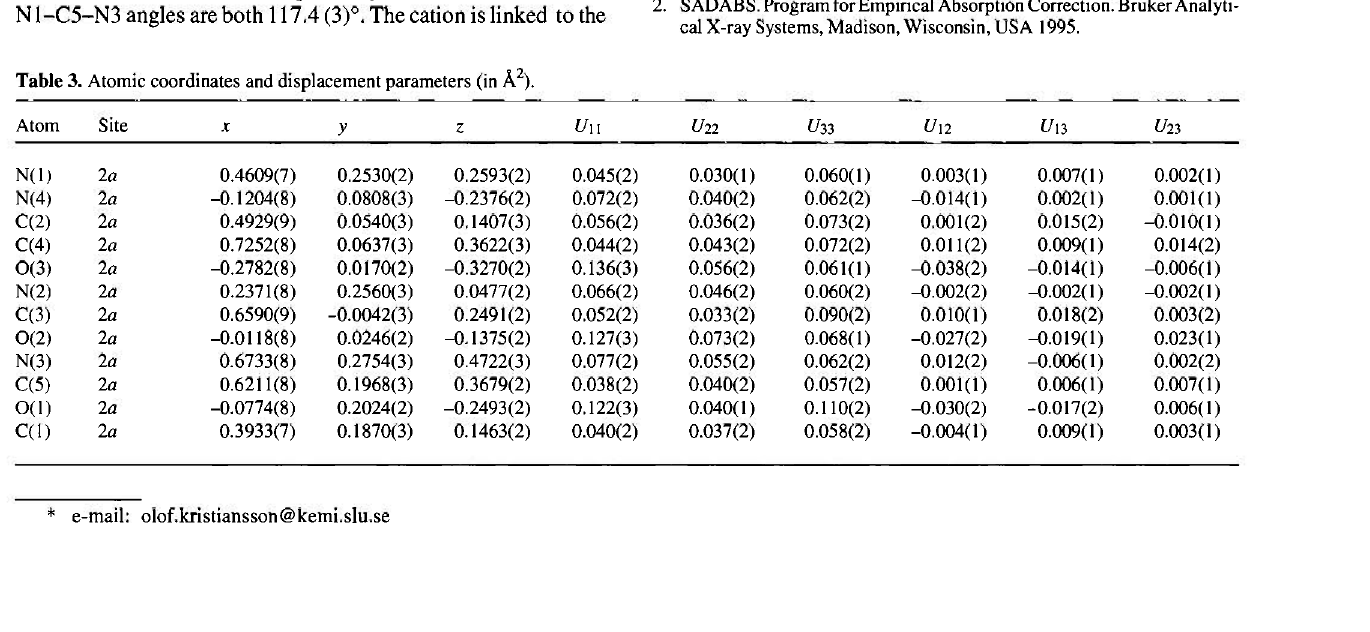
Table 2. Atomic coordinates and displacement parameters (in Ä 2